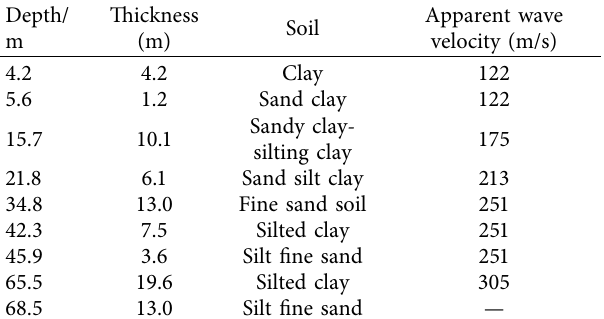
Table 1: The basal apparent wave velocity of the EI-Centro station.